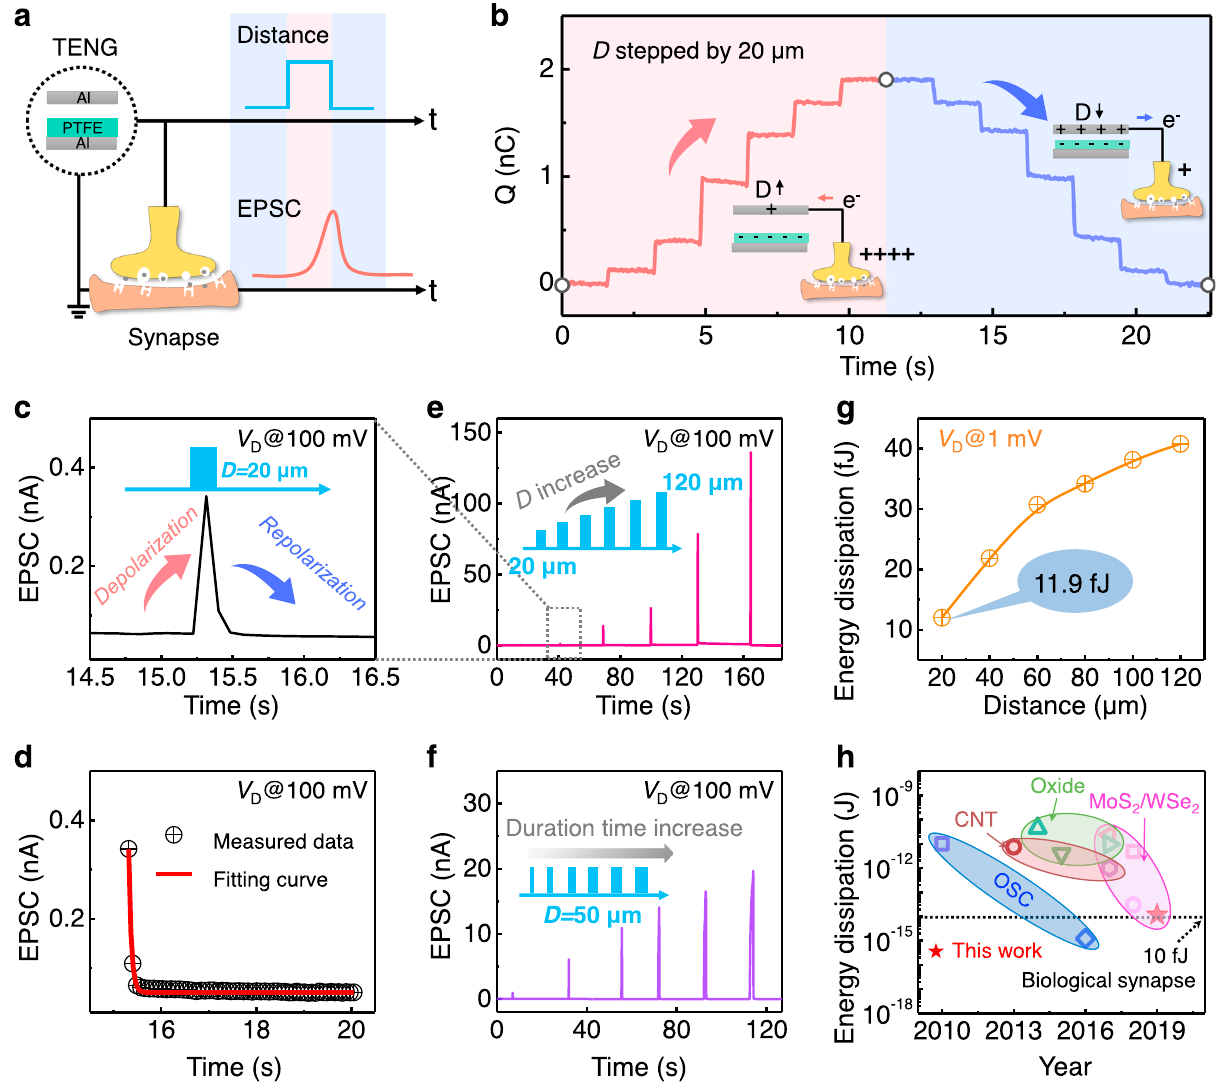
Fig. 2 Typical synaptic characteristics of the CE-activated arti fi cial afferent. a Schematic illustration of an EPSC activated by a single CS action. b The transferred charges of the CE-activated MoS 2 synaptic transistor within a cycle of contact-separation. c The EPSC responses under one CS action ( D = 20 μ m). d The decay phenomenon fi tting of the EPSC with the exponential decay model (Supplementary Note 3). e The EPSCs under different CS action distances. Inset: D increases from 20 to 120 μ m. f The EPSC responses under different CS action durations ( D = 50 μ m). Inset: Illustration of the increase in duration. g The energy dissipation vs. distance. h Comparison of the energy dissipation per spike for different types of arti fi cial synapses. The dissipation is 11.9 fJ in the CE-activated arti fi cial afferent (red